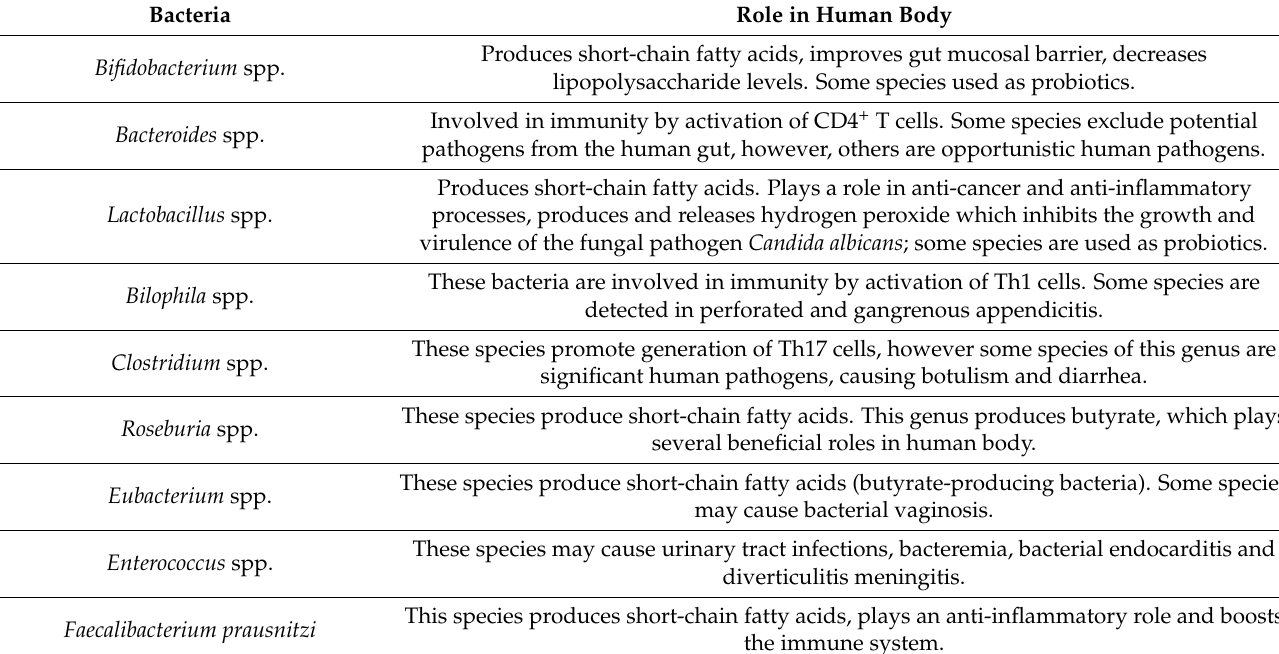
Table 2. Roles of selected human gut bacteria. For details, please see